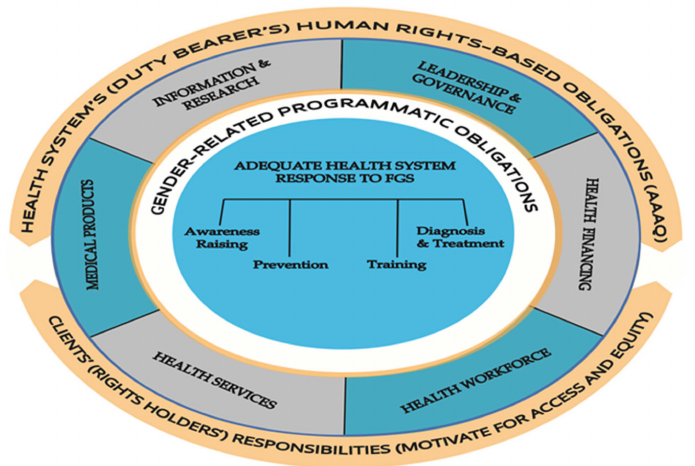
Figure 1. The reciprocal relationship between the health system in the gender-sensitive human rights-based framework for female genital schistosomiasis